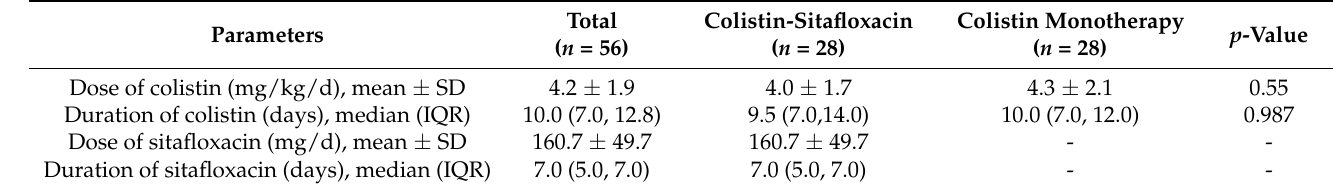
Table 2. Dose and duration of colistin and sitafloxacin among total patients, and compared between the combination and monotherapy